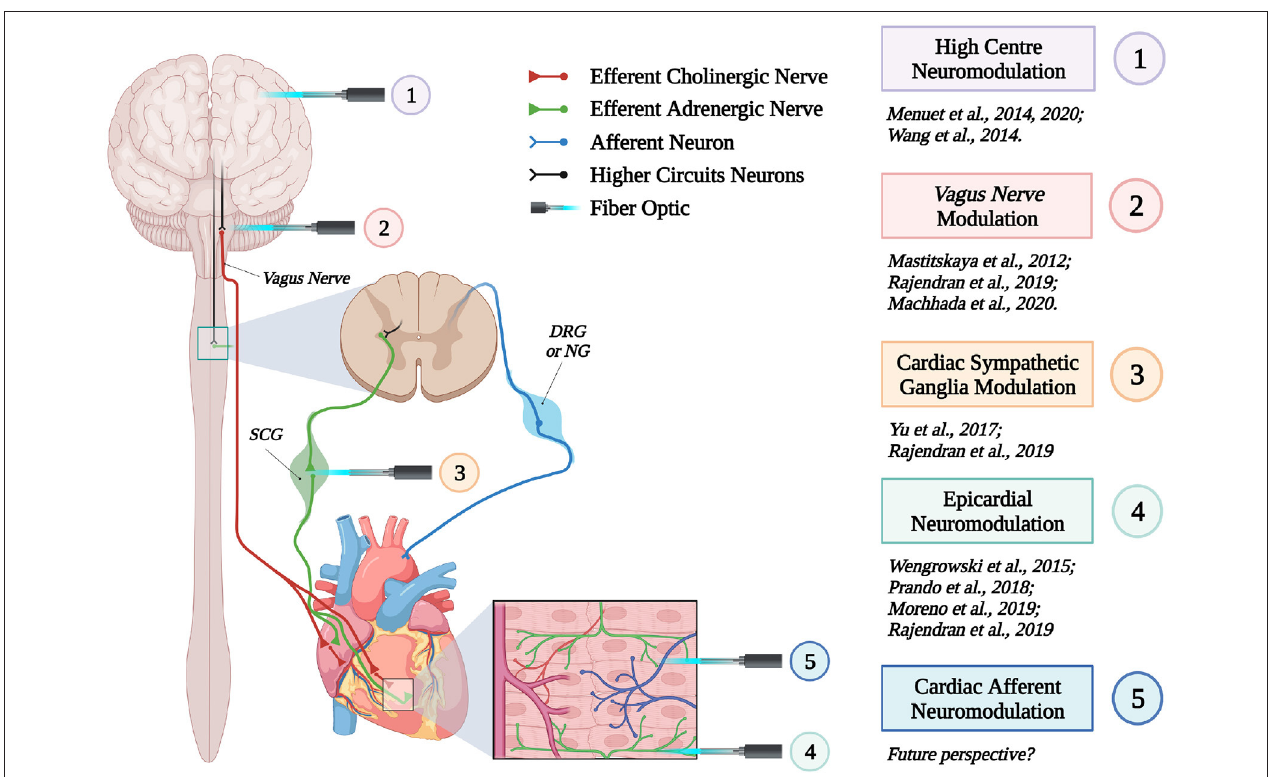
FIGURE 3 | Optogenetic interrogation of the brain–heart axis at multiple sites. Schematic representation of the different brain–heart connecting circuitries which have been or could be interrogated by optogenetics (created with